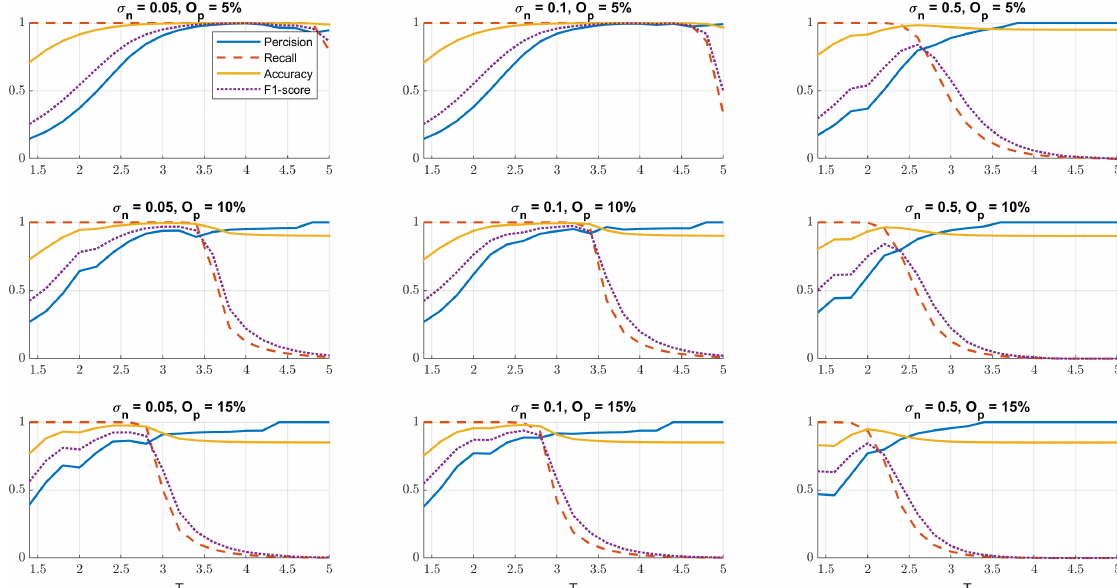
Figure 4. Results of sensitivity analysis; performance of the outlier detection algorithm with respect to different values of the chosen